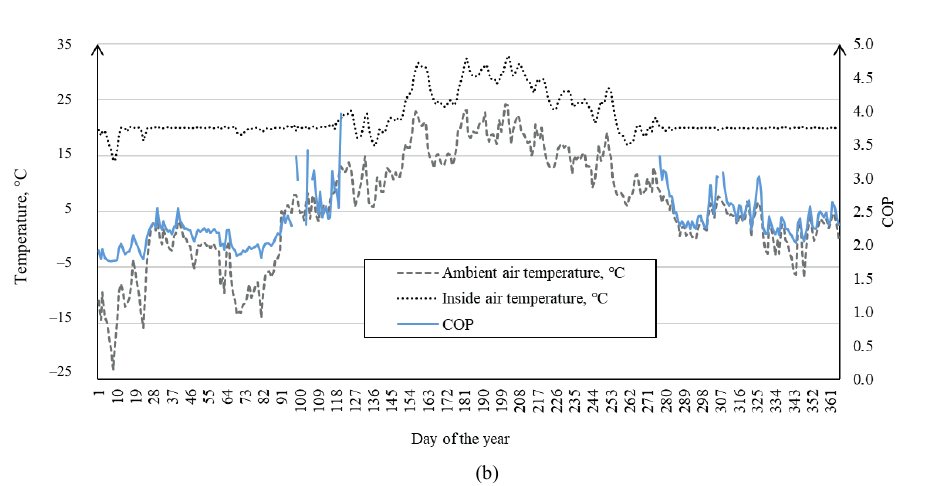
Fig. 7. COP dependence on ambient air temperature in: a) Tallin and b)